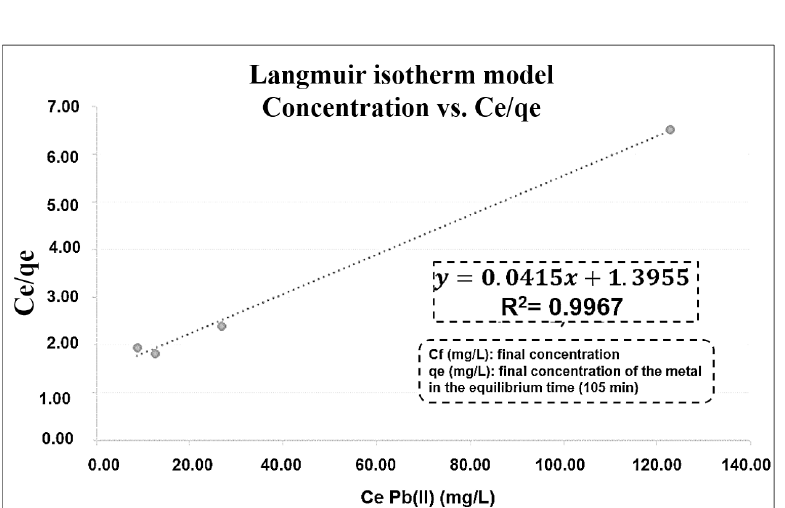
Figure 4. Adsorption isotherm for Pb(II) with CP. Table 4. Capacity of maximum adsorption in coffee wastes without chemical modification.